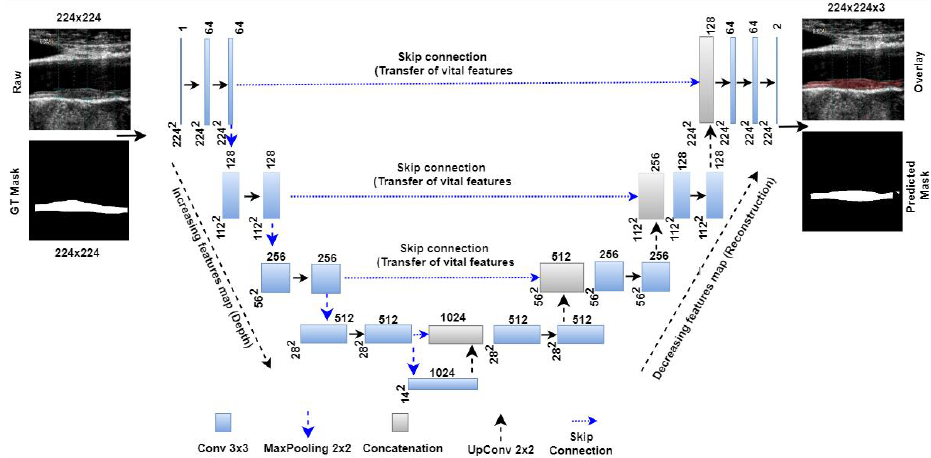
Figure 10. UNet model for segmentation of the wall of an atherosclerotic plaque [121].